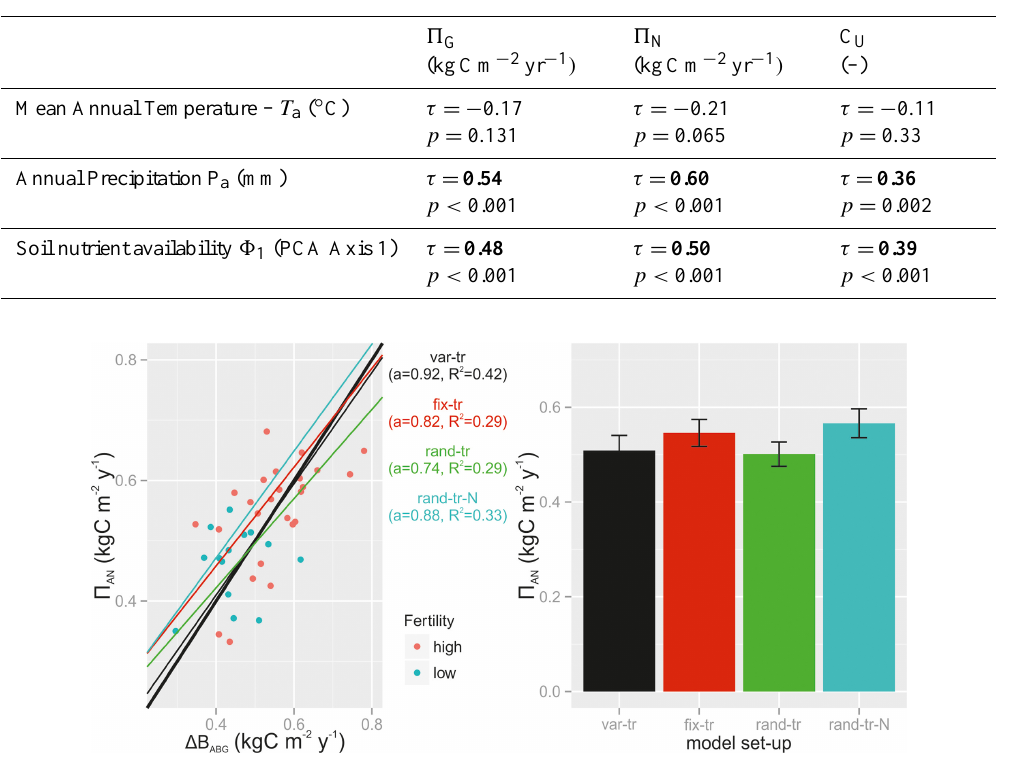
Figure 6. Summary of the randomisation exercise simulations. (a) Simulated stand-level aboveground net primary productivity ( 5 AN ) against observed stand-level aboveground biomass growth ( 1B ABG ) for the four different setups. The slope of the SMA ( a ) and the adjusted R 2 are given in parentheses for each setup. Different colours indicate different setups. (b) Simulated Amazon-wide aboveground net primary productivity ( 5 AN ) for the four different